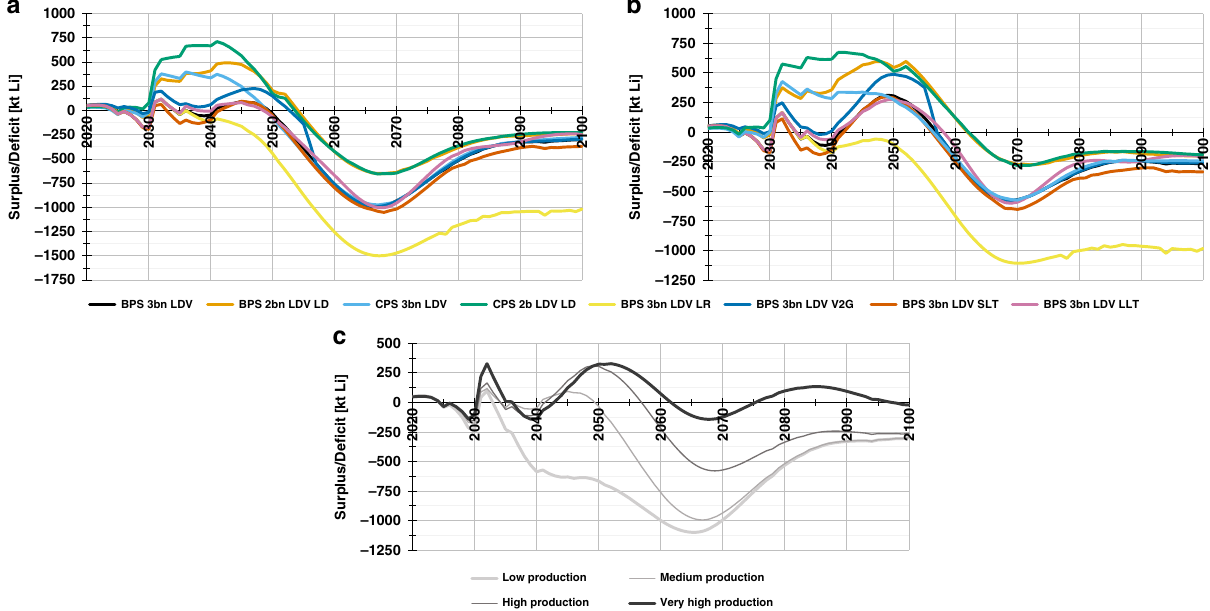
Fig. 3 Annual comparison of Li production and fresh demand. Annual Lithium supply and demand balance. The annual surplus or de fi cit of lithium for a scenarios involving medium production; b scenarios involving high production; c various production scenarios under the BPS 3b LDV demand